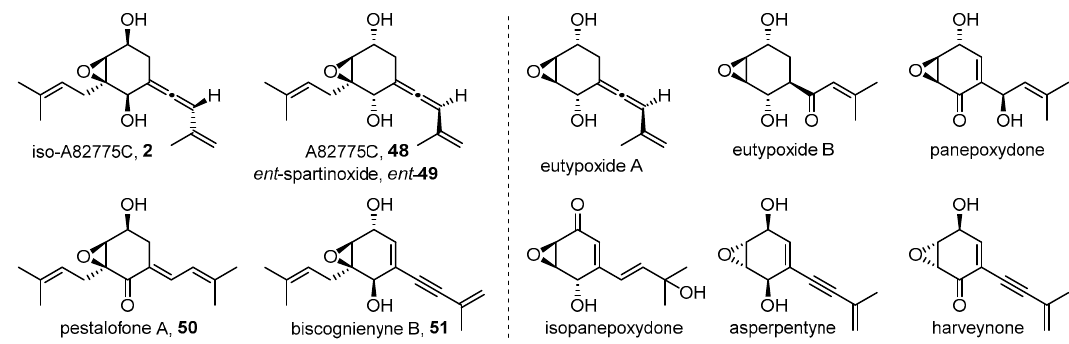
Figure 3. The chemical structure of iso-A82775C and its related natural products.